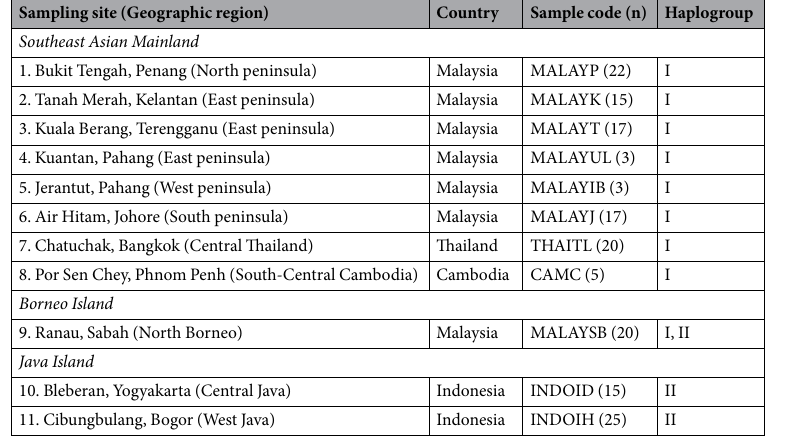
Table 1. Sampling sites and distribution of Haematobia exigua haplogroups in Southeast